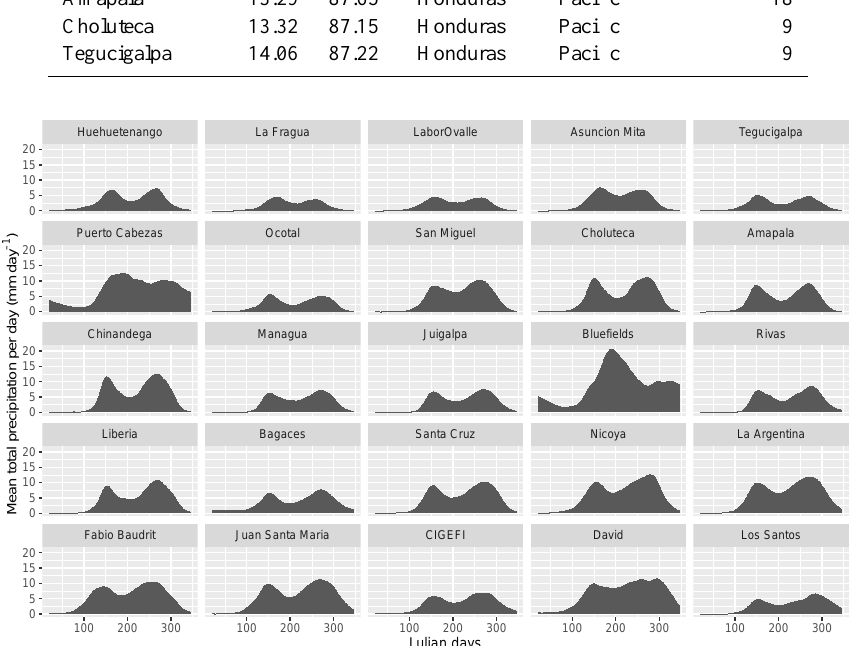
Figure 2. Annual cycle of precipitation in every station for the period 1961–2012.